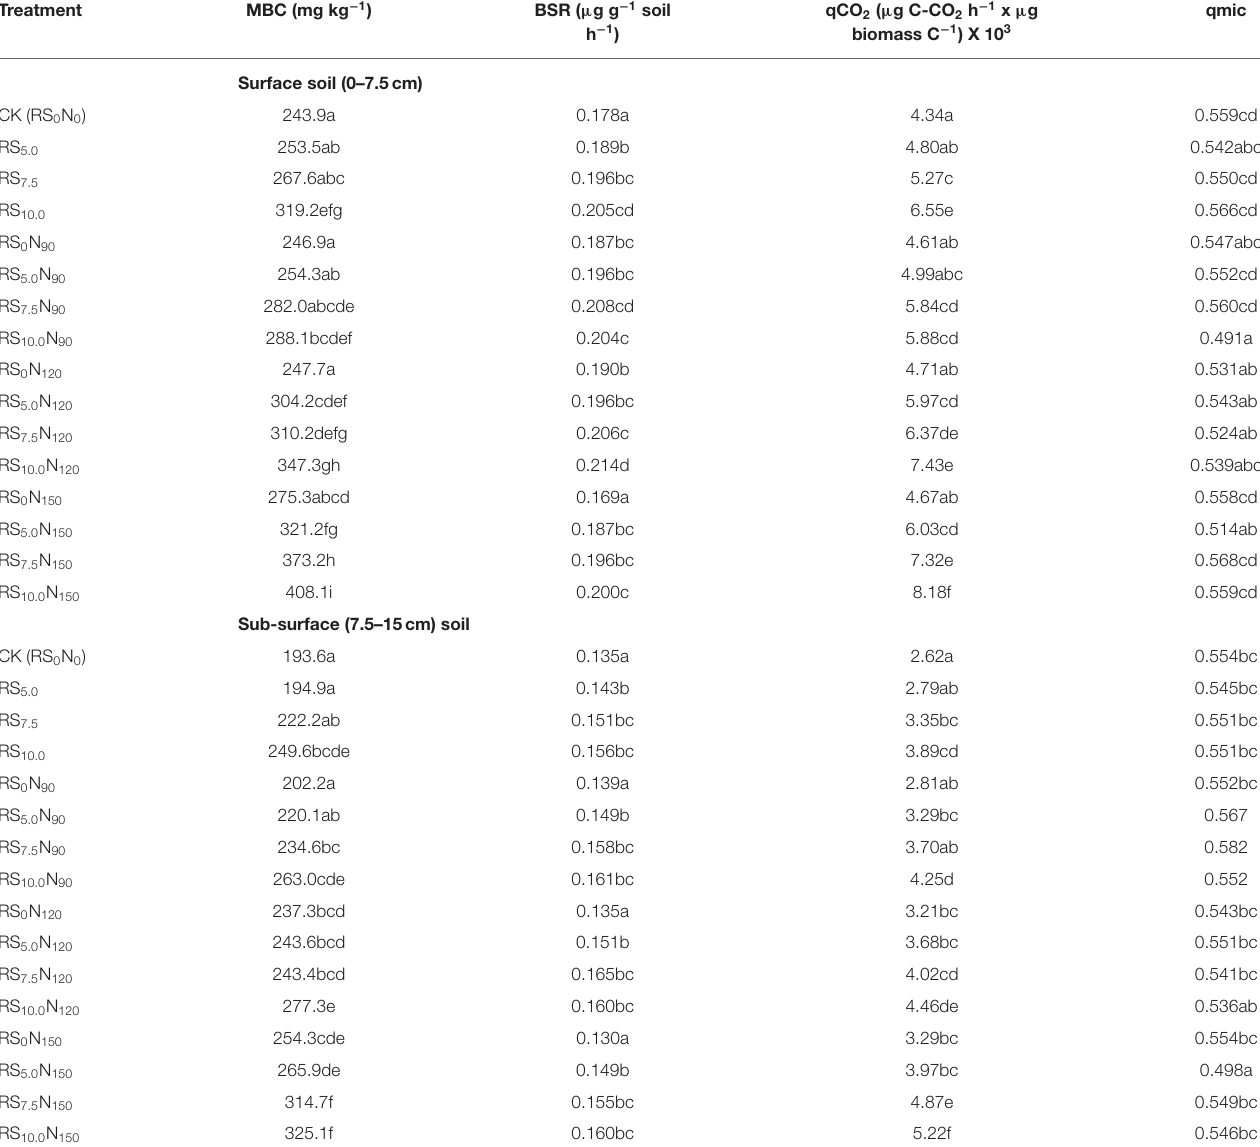
TABLE 5 | Effect of fertilizer-N application and rice straw (RS) incorporation on microbial biomass carbon (MBC), basal soil respiration (BSR), respiratory (qCO 2 ), and microbial (qmic) quotients of surface (0–7.5cm) and sub-surface (7.5–15cm) soil depth under rice-wheat cropping system in north-western India.